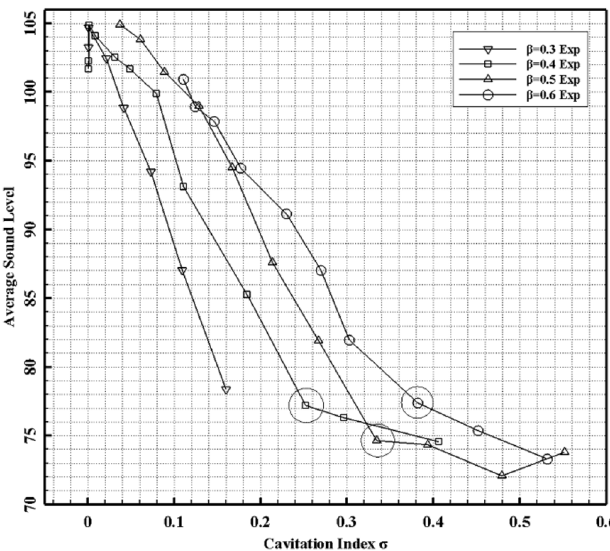
Fig. 7. The trend of ASL with the cavitation index change for different ori fi ces. (The horizontal axis is in the logarithmic scale).